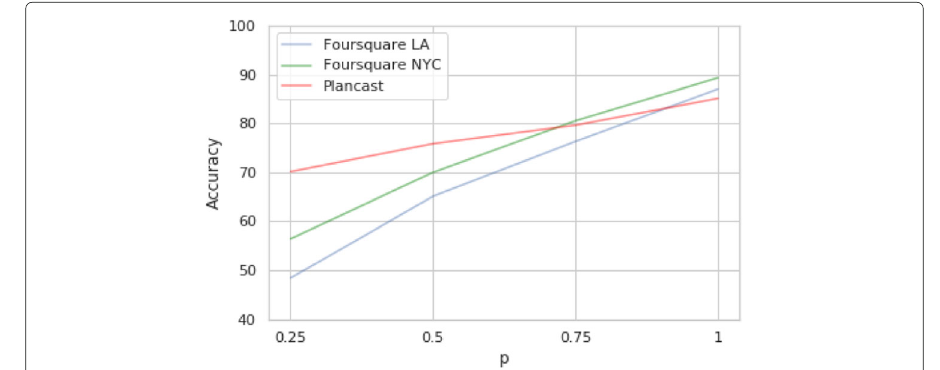
Fig. 9 Prediction Accuracy at varying sharing probability